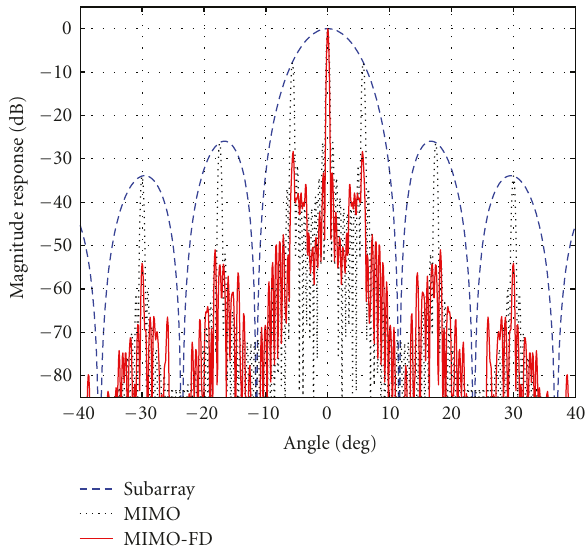
Figure 6: Beam pattern for MIMO and MIMO-FD arrays with the sparse distance L = 20 λ 0 /